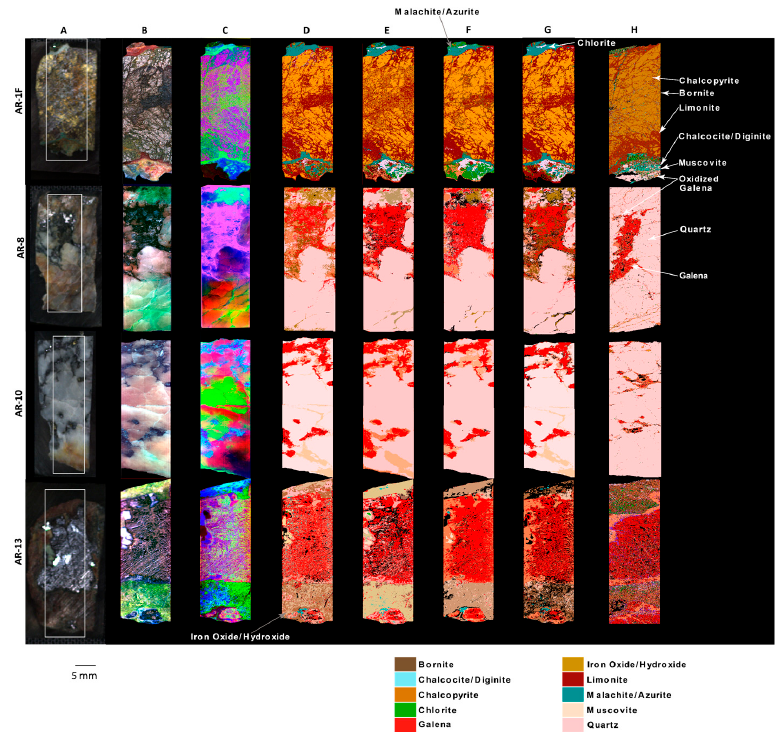
Figure 11. Sulfide samples ( A ) True color composite with the high-resolution scan area outlined in white. ( B ) SWIR false color composite AR1-F: 2102, 1359, 953 nm; AR-8: 934, 1819, 2447 nm; AR-10: 934, 1819, 2447 nm; and AR-13: 2453, 1794, 966 nm. ( C ) MNF color composites AR1-F: 1, 3, 2 AR-8 and AR-10: 3, 2, 1; and AR-13: 1, 2, 4. ( D ) SAM, ( E ) SVM, and ( F ) Neural Net classifications. ( G ) A combination of classes that most closely match QEMSCAN abundances, as shown by outlined cells of Table 2. ( H ) QEMSCAN image that has been subset to approximately the same extent as the hyperspectral imagery. Legend colors apply to images D–H. The scale bar applies to